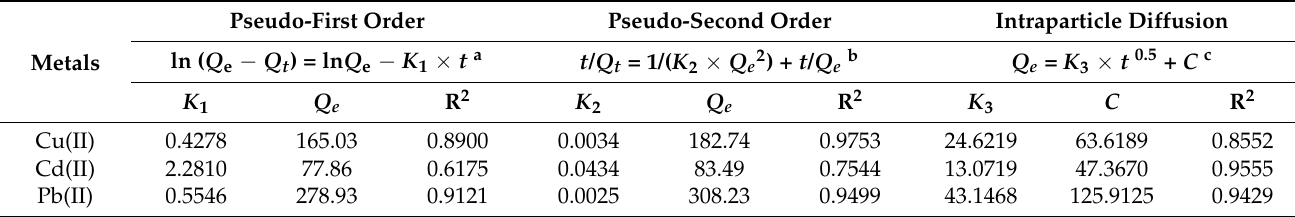
Table 2. Sorption kinetic parameters for Cu(II), Cd(II) and Pb(II) sorption onto 15%Mg-BC. Pseudo-First Order Pseudo-Second Order Intraparticle